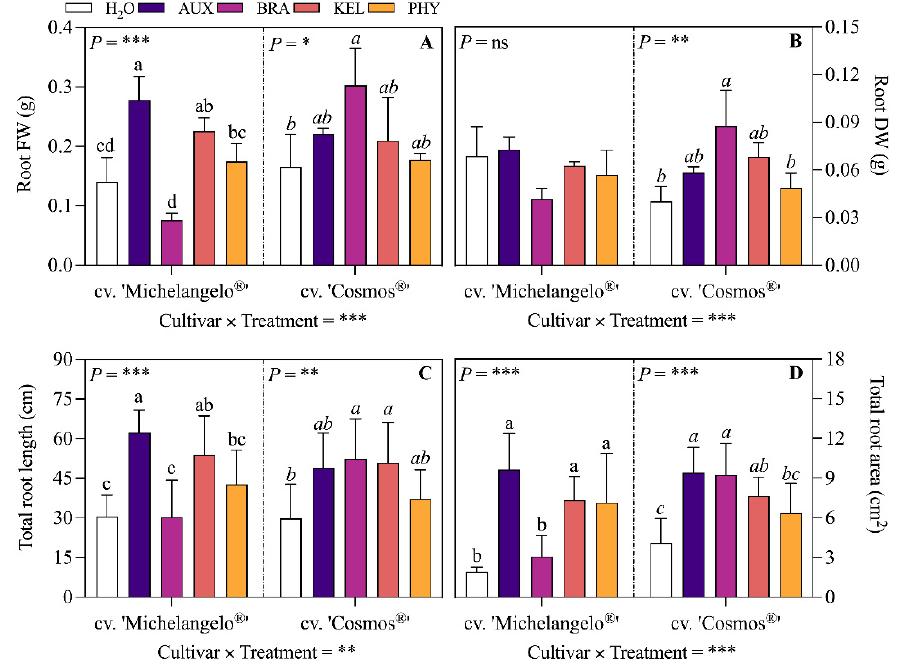
Figure 4. Root fresh weight ( A ), dry weight ( B ), length ( C ), and area ( D ) of cv. ‘Michelangelo ® ’ and ‘Cosmos ® ’ cuttings, after 14 weeks from the treatments. Cuttings were treated with: H 2 O = distilled water; AUX = auxins; BRA = homobrassinolide; KEL = Kelpak ® ; PHY = Phylgreen. Two-way and one-way ANOVA p -values and Tukey’s post hoc comparisons are reported in the figure (* p < 0.05, ** p < 0.01; *** p < 0.001; ns, not significant). Letters in the figure indicate the level of difference significance.